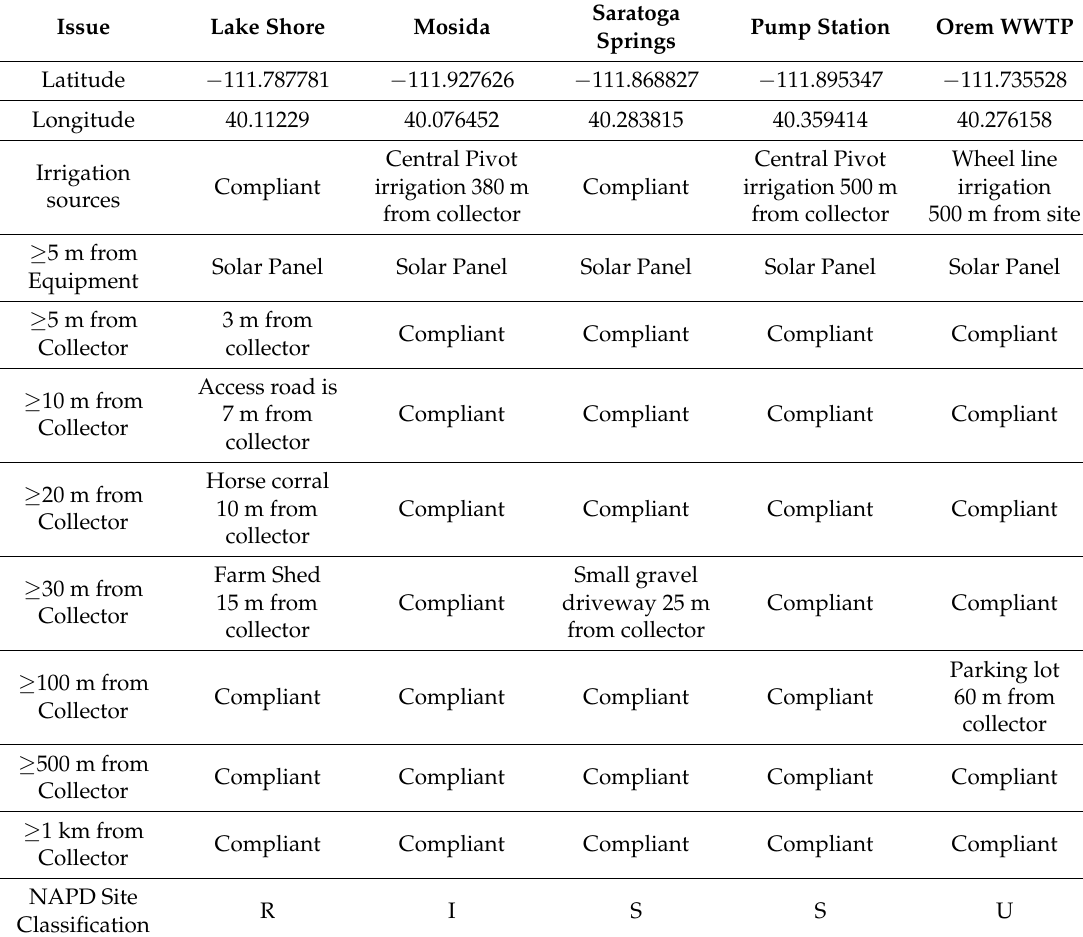
Table 1. Site information and compliance of each site with NAPD site selection protocols. Not